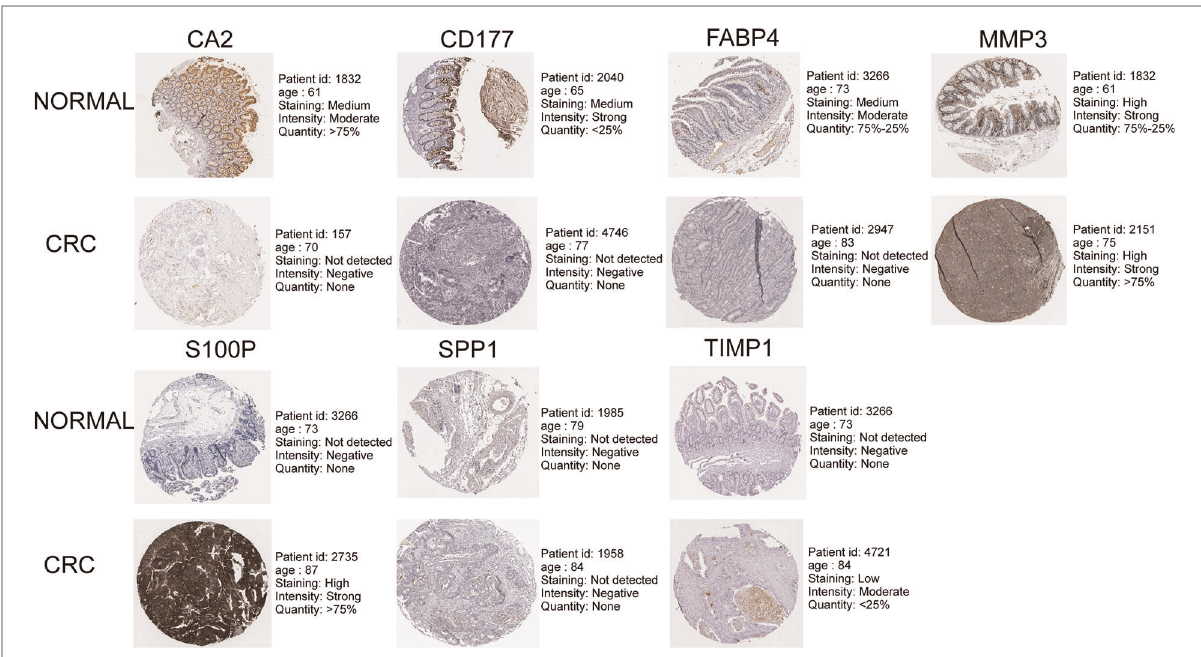
FIGURE 9 Immunohistochemistry images of UC-related prognostic genes obtained from the human protein atlas (HPA) database.